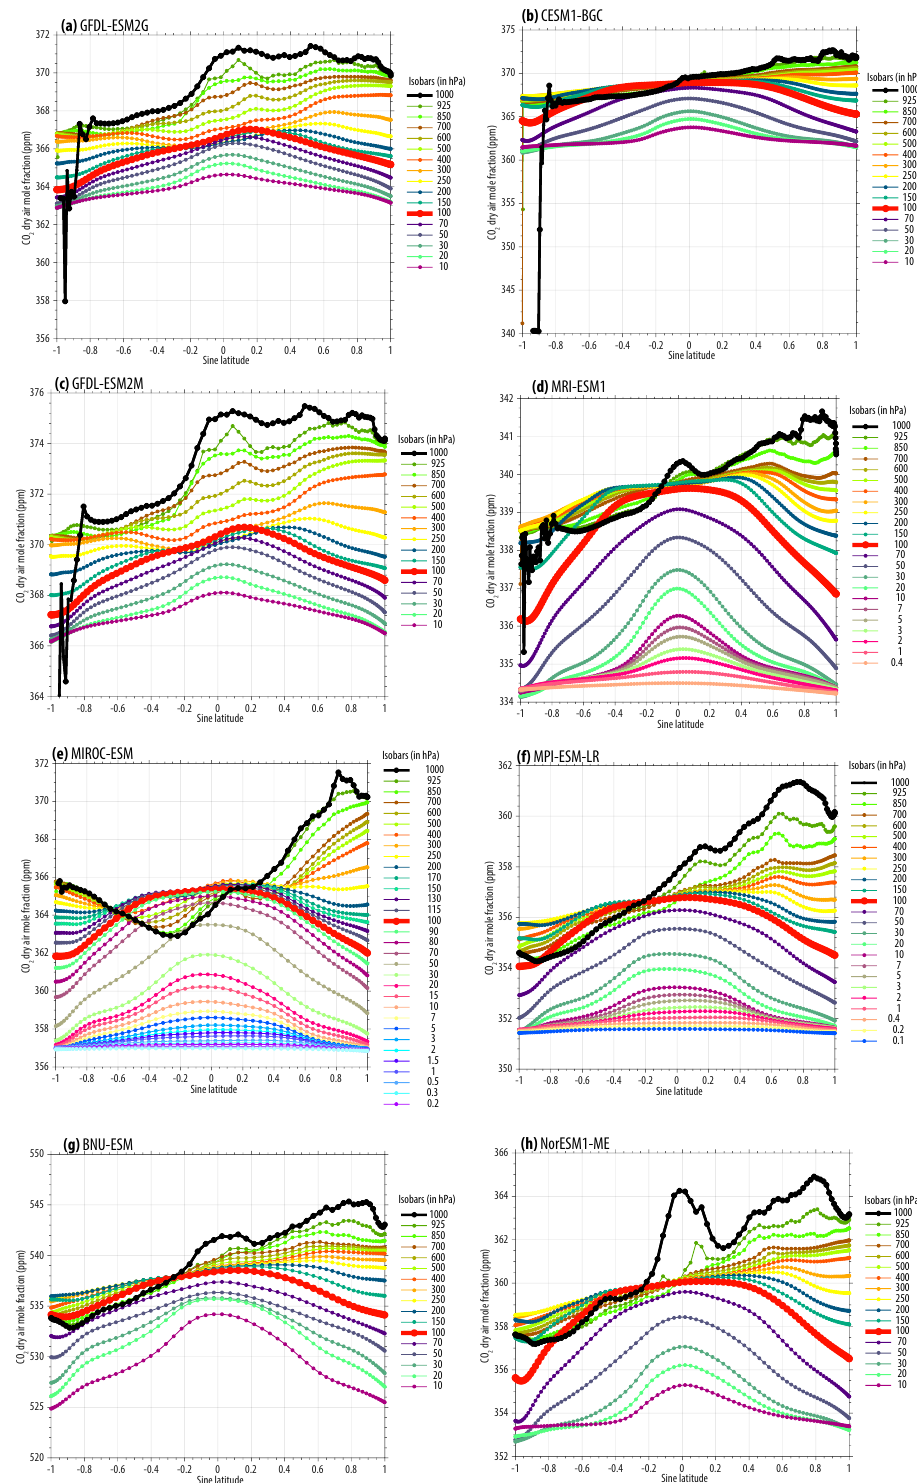
Figure 13. CMIP5 ESMs vertical mole fraction averages at the provided pressure levels – averaged over the 30-year period 1976–2005. The black line indicates surface mole fractions at the 1000hPa pressure level. The red bold line indicates mole fractions at the 100hPa level (cf. Fig. 14a and